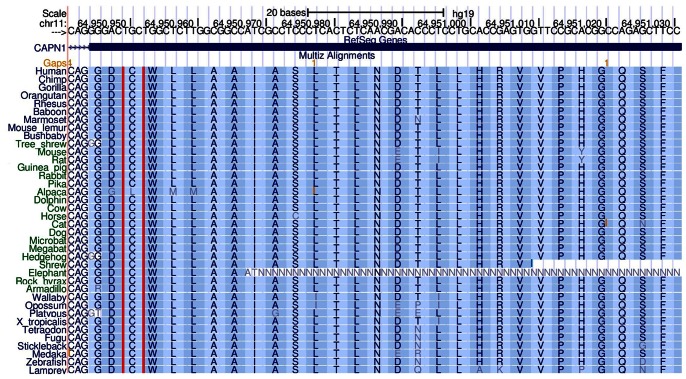
Multispecies alignment across residue 115 of the calpain peptide.Alignment across 46 vertebrate species visualised using the UCSC genome browser (human genome build hg19) to assess the level of cross-species conservation for the CAPN1 gene.